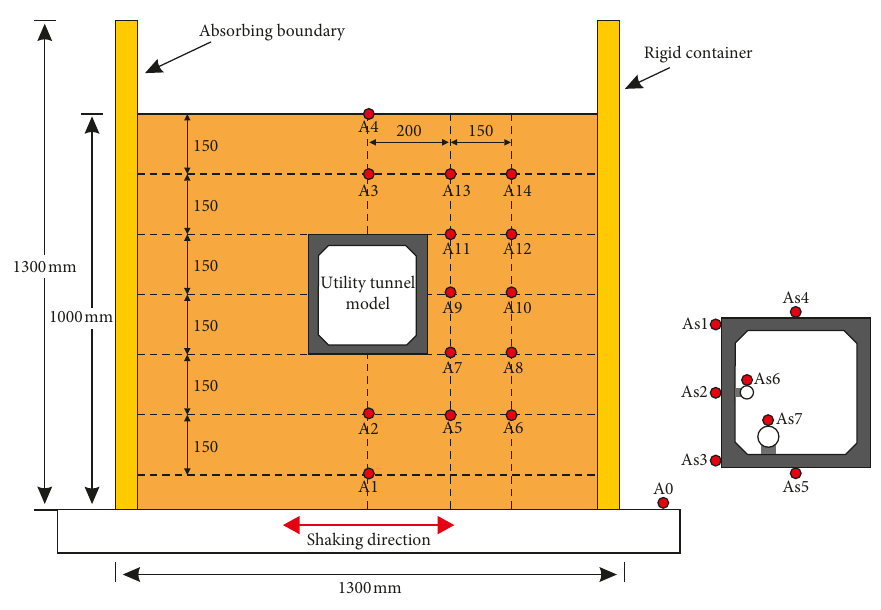
Figure 4: Arrangement of accelerometers embedded in the soil and structure.